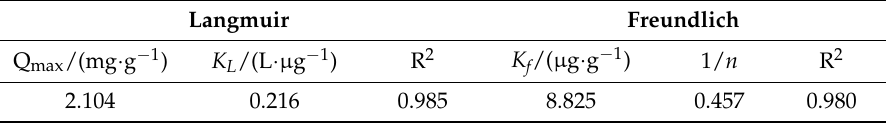
Table 3. Parameters calculated by the Langmuir and Freundlich isotherm models for the adsorption of Pb(II) on nano I-S m.